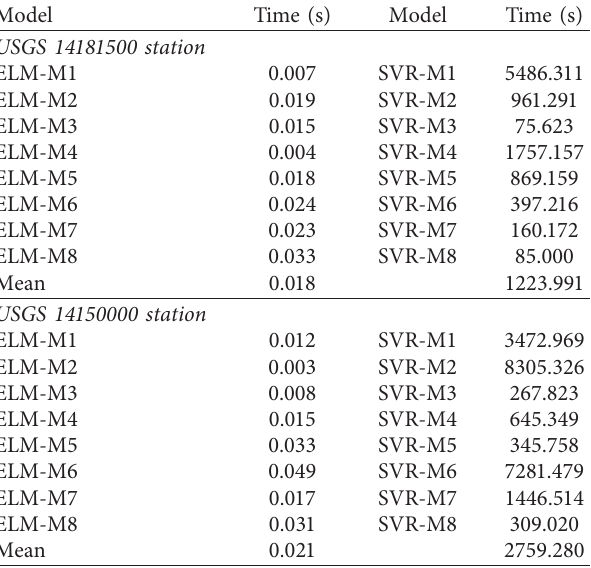
Table 7: The computational time required for the training phase from each